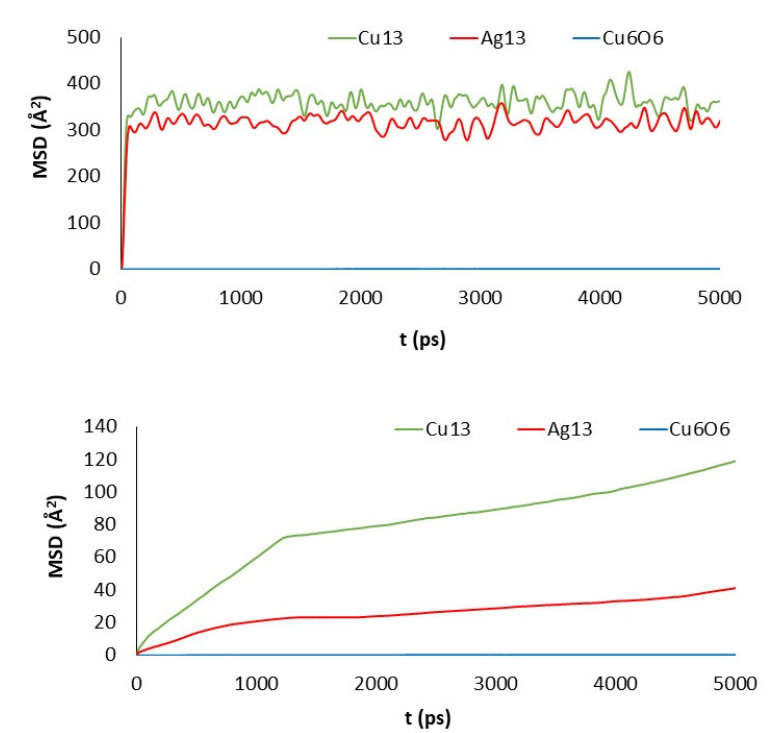
Figure 7. MSD of the clusters versus simulation length: PGN (top) and GO_PEG_N (bottom).